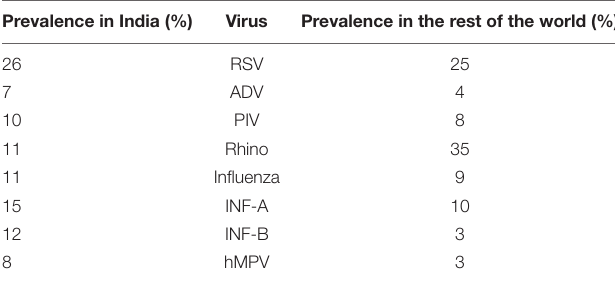
TABLE 4 | Comparison of the detection rates of viruses in India with those of other parts of the